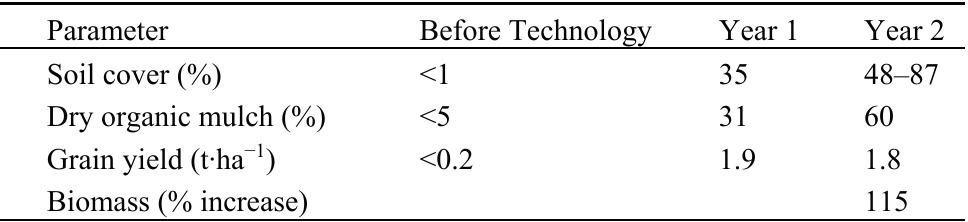
Table 2. Some indicators of biophysical impact of pigeon-pea technology in the Ribeira Seca Watershed (RSW) at field scale. Source: [10,48 ]